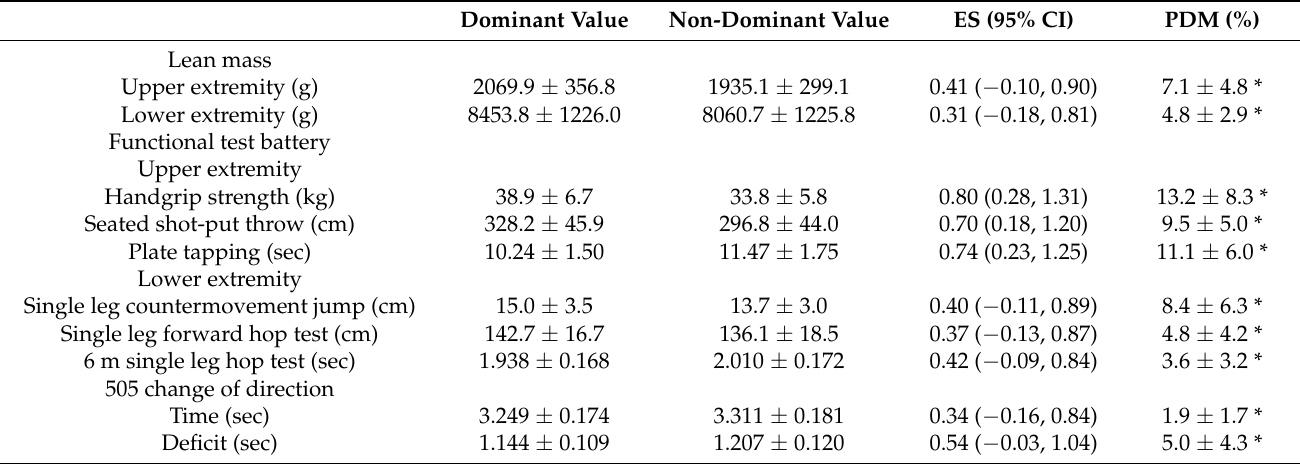
Table 3. Upper and lower extremity lean mass and functional asymmetry values of the high-level female tennis players (N = 22).